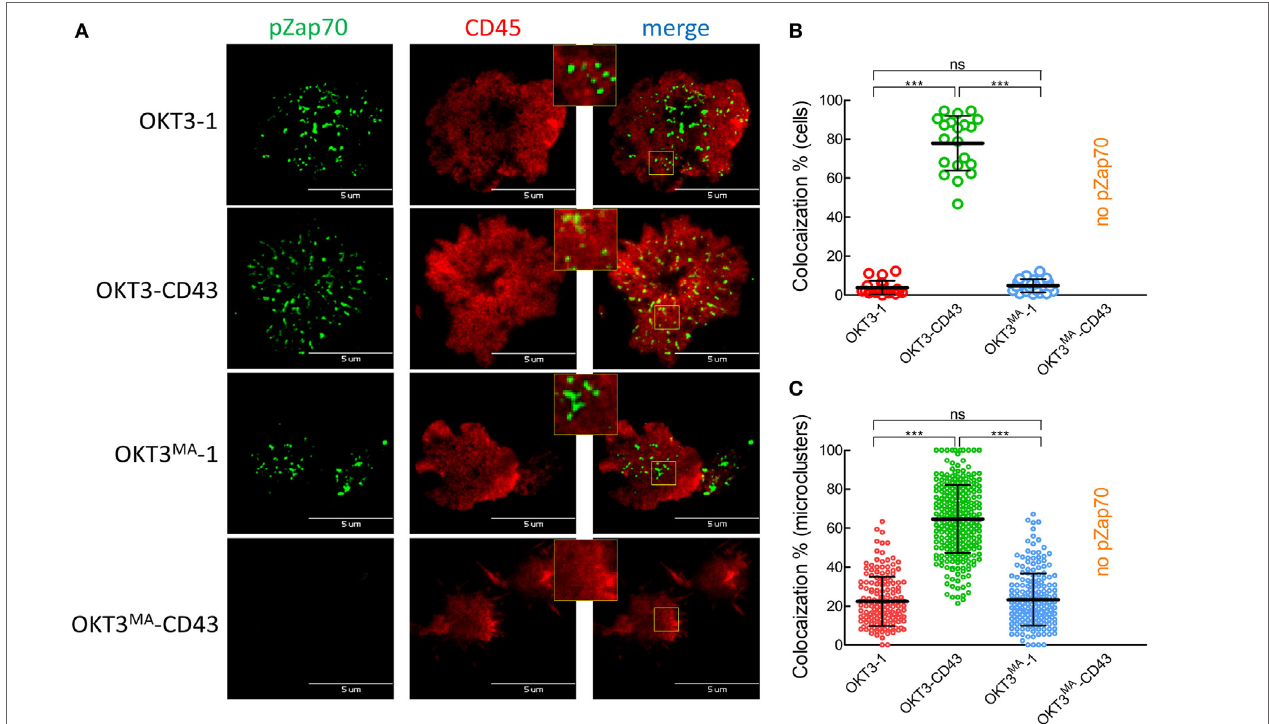
FigUre 7 | CD45 partially segregates from pZap70 when triggering T cells with OKT3-CD43. (a) Jurkat T cells were placed over planar lipid bilayers decorated with the scFv ligands, fixed after 3 min, and stained for pZap70 (green), and CD45 (red). Small yellow squares are enlarged. (B) Co-localization percentage between pZap70 and CD45 measured by intensity of overlapped pixels for whole Jurkat cells activated by different ligands. (c) Co-localization percentage between pZap70 and CD45 measured by intensity of the overlapped pixels for individual microclusters obtained from Jurkat cells and activated by different ligands ( n = 20 cells per ligand). Bars,